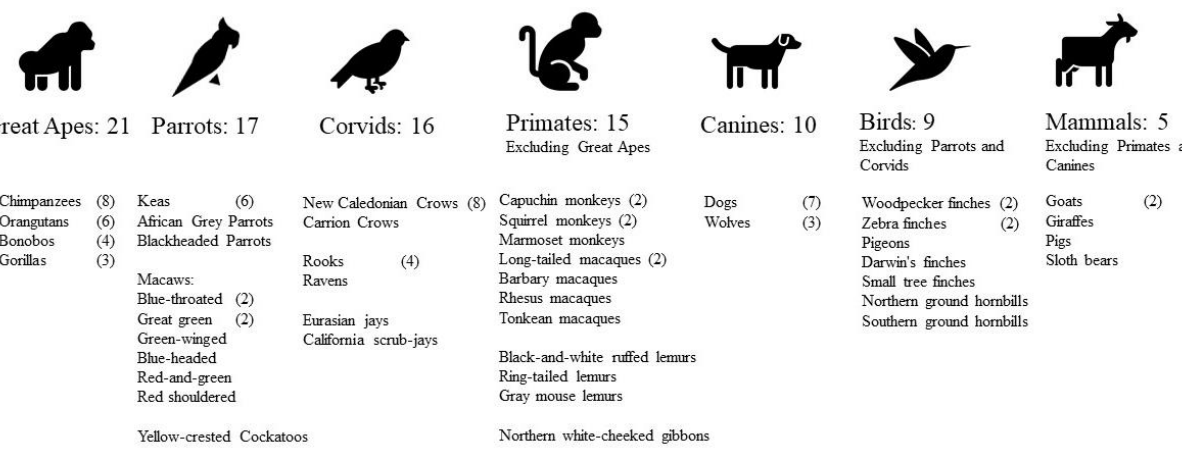
Note . The sample consisted of behavioral experiments on captive animal physical cognition and was sampled using a Scopus search for "folk physics" OR "physical cognition," and a variety of trap-tube and trap-table combinations. If a species was in more than one paper, this number is given in brackets after the species; e.g., there were 8 papers that included chimpanzees in the sample, and two papers including